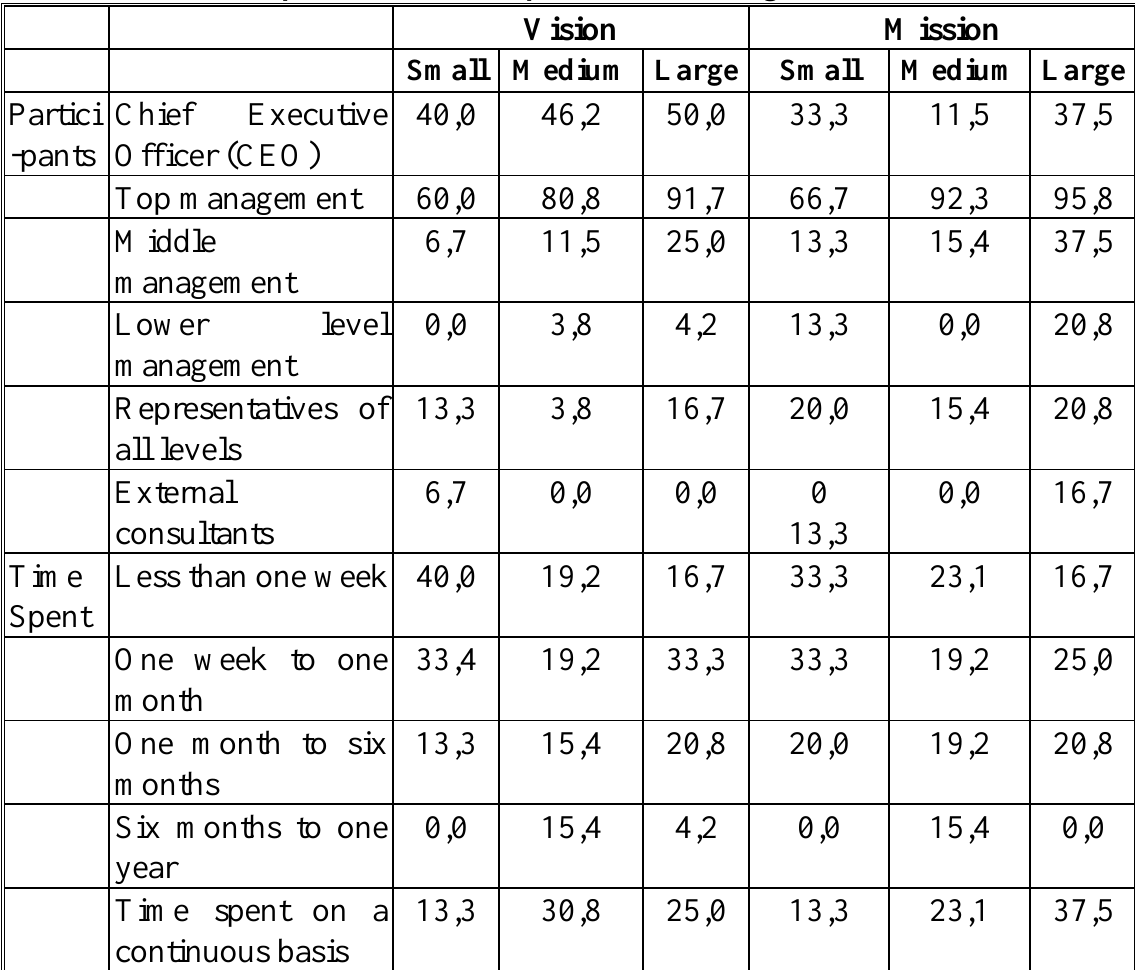
Table 3 Participants and time spent formulating the vision and mission Vision Mission Small Medium Large Small Medium